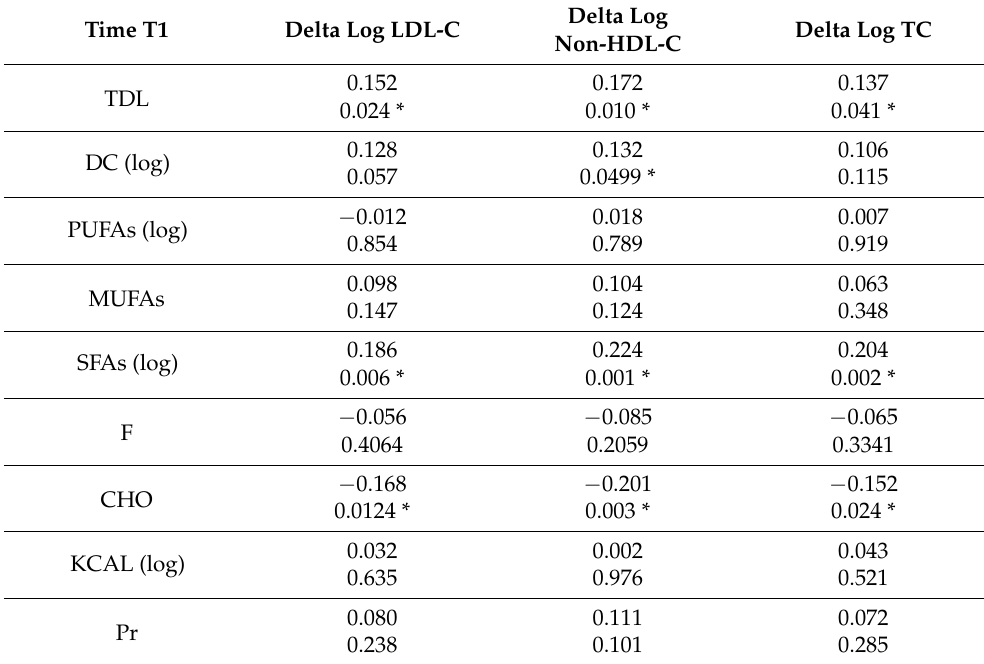
Table 4. Pearson’s partial correlation index between macronutrients at T1 and serum lipid variation, sex and age